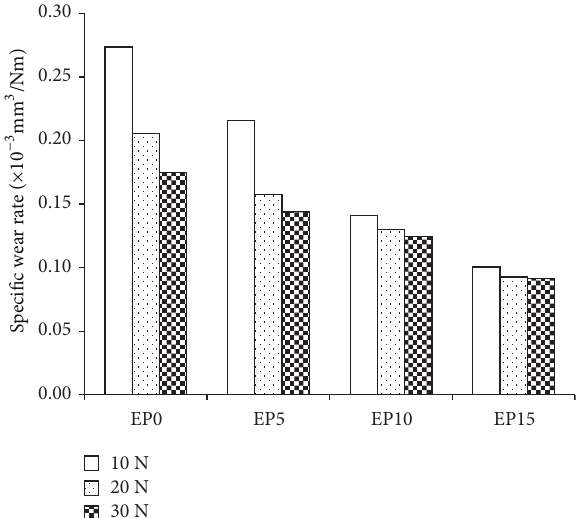
Figure 9: Variations of the specific wear rate with respect to sliding distance for different material compositions (30 N, 1 m/s).